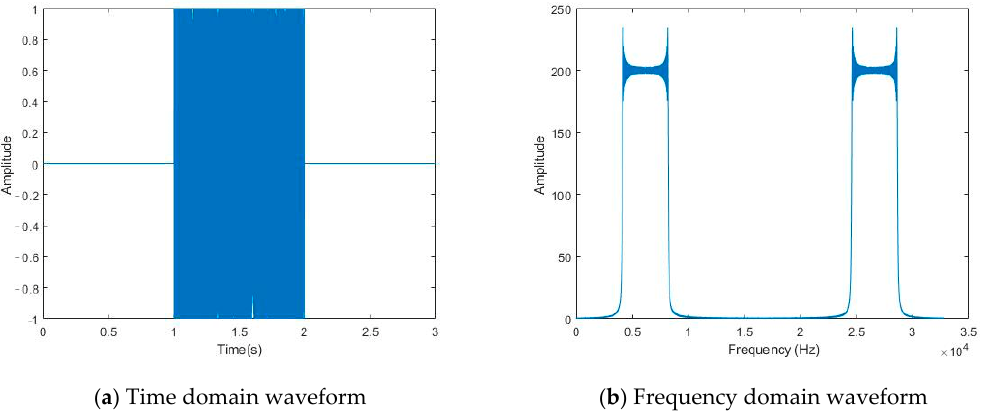
Figure 11. Simulation of time domain and frequency domain waveforms of the transmit signal.